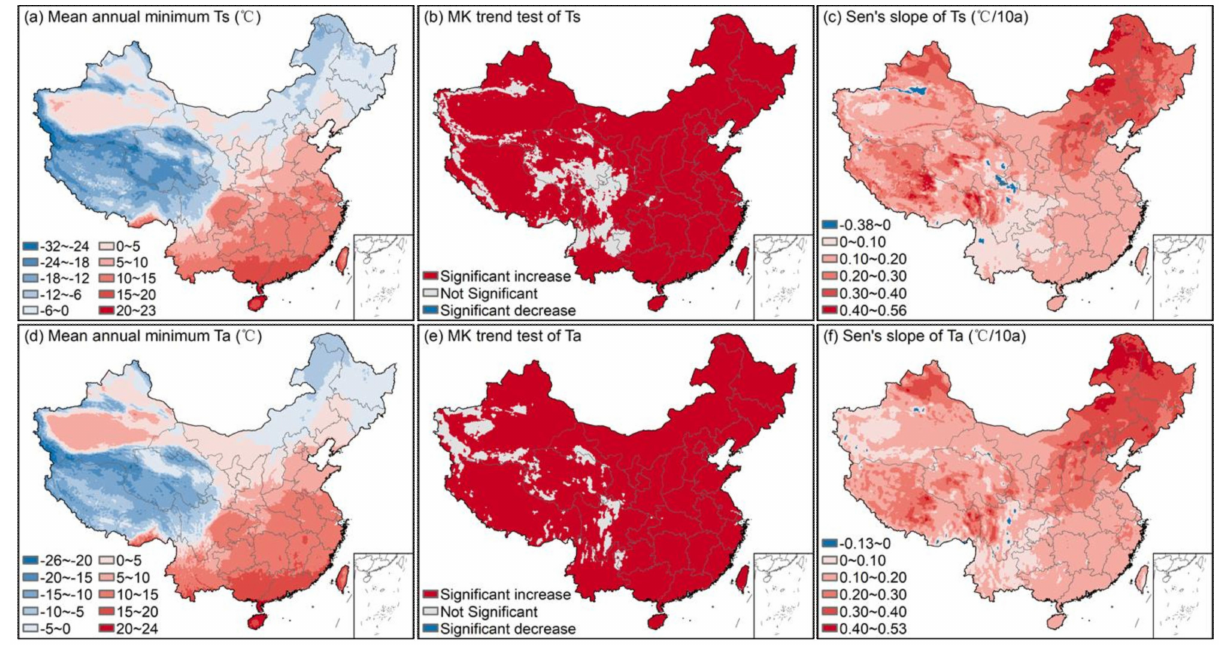
Figure 4. Spatial distribution of annual mean minimum T s and T a . ( a ) Trends of annual mean minimum T s based on the Mann–Kendall trend test (95% confidence level), ( b ) Sen’s slope of the annual mean minimum T s , ( c ) annual mean minimum T a , ( d ) trends of annual mean minimum T a based on the Mann–Kendall trend test (95% confidence level), ( e ) Sen’s slope of the annual mean minimum T a ( f ) across China during the